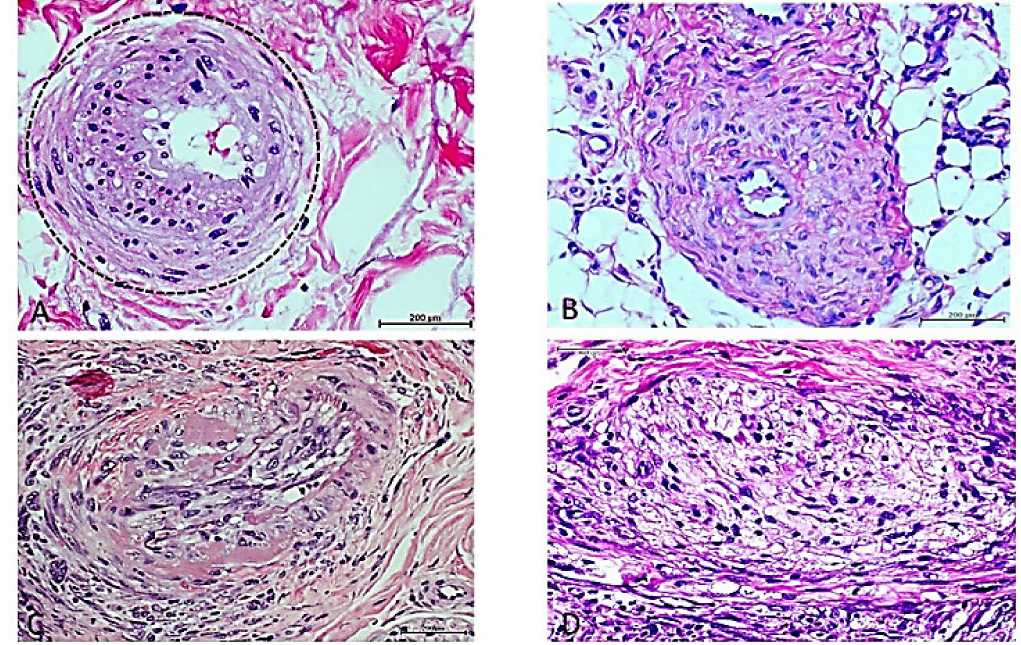
Figure 2. Rats’ arteriolar remodeling after exposure to non-diabetic arteriosclerotic arterial tissue. ( A ) Human donor arteriole with an active process of intimal hyperplasia, subendothelial infiltration, luminal narrowing and concentric expansion of the media layer with large basophilic nuclei. H/E. Magnification × 40. ( B ) Vascular response to human arteriosclerotic material in which a rat arteriole exhibits wall thickening, abnormal cellular infiltration, and disorganization. There is an exaggerated accumulation of collagen bundles. The lumen is obliterated. H/E. Magnification × 40. ( C ) Human donor arteriole showing degenerative wall changes including accumulation of hyaline material and internal tunica elastica fragmentation. Endothelial cells are hypertrophied and intermixed with fibroblast-like cells that appear to emerge from the endothelial collar and make up a mesh-like structure that encroaches into the lumen. H/E. Magnification × 40. ( D ) Rat’s arteriole with luminal invasion by protruding fusiform-like cells that emerge from the endothelial side and project into the lumen, forming a trabecular structure. The luminal mesh is infiltrated by round basophilic nuclei, suggestive of lymphocytes and other of fibroblastic aspect. H/E. Magnification: × 40. Scale bar: 200 µ